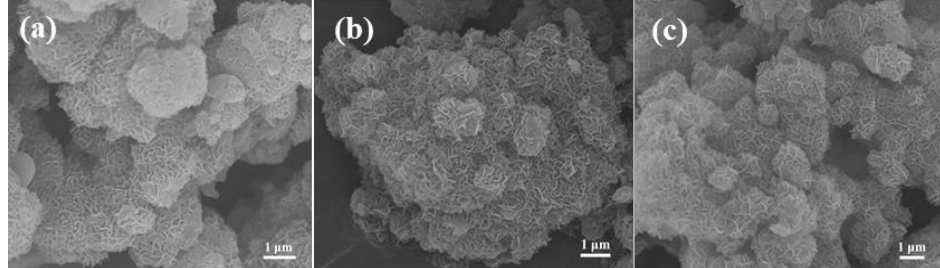
Figure 3. SEM images of NSC ( a ), NSC-600 ( b ), and NSC ox-2 ( c ).